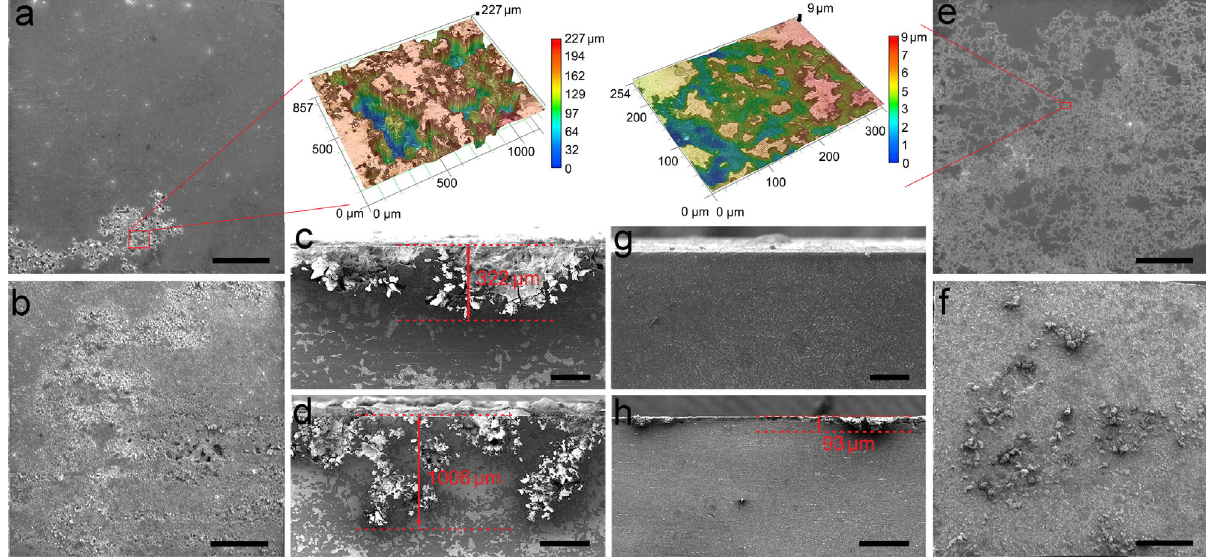
Fig. 4 Corrosion morphology after exposure to 3 wt.% NaCl solution. AZ80-T6 after ( a ) 24 h and ( b ) 168 h, scale bar = 2 mm in a and b ; aged UFT-4 after ( e ) 24 h and ( f ) 168 h, scale bar = 2 mm in ( e ) and ( f ). Cross-sectional views of AZ80-T6 after ( c ) 24 h and ( d ) 168 h, scale bar = 200 μ m in ( c ) and scale bar = 500 μ m in ( d ). Cross-sectional views of aged UFT-4 after ( g ) 24 h and ( h ) 168 h, scale bar = 200 μ m in ( g ) and scale bar = 500 μ m in ( h and 1000 µm after 168 h (Fig. 4d). In contrast, homogeneous and one, which greatly affects the applications of Mg products. A